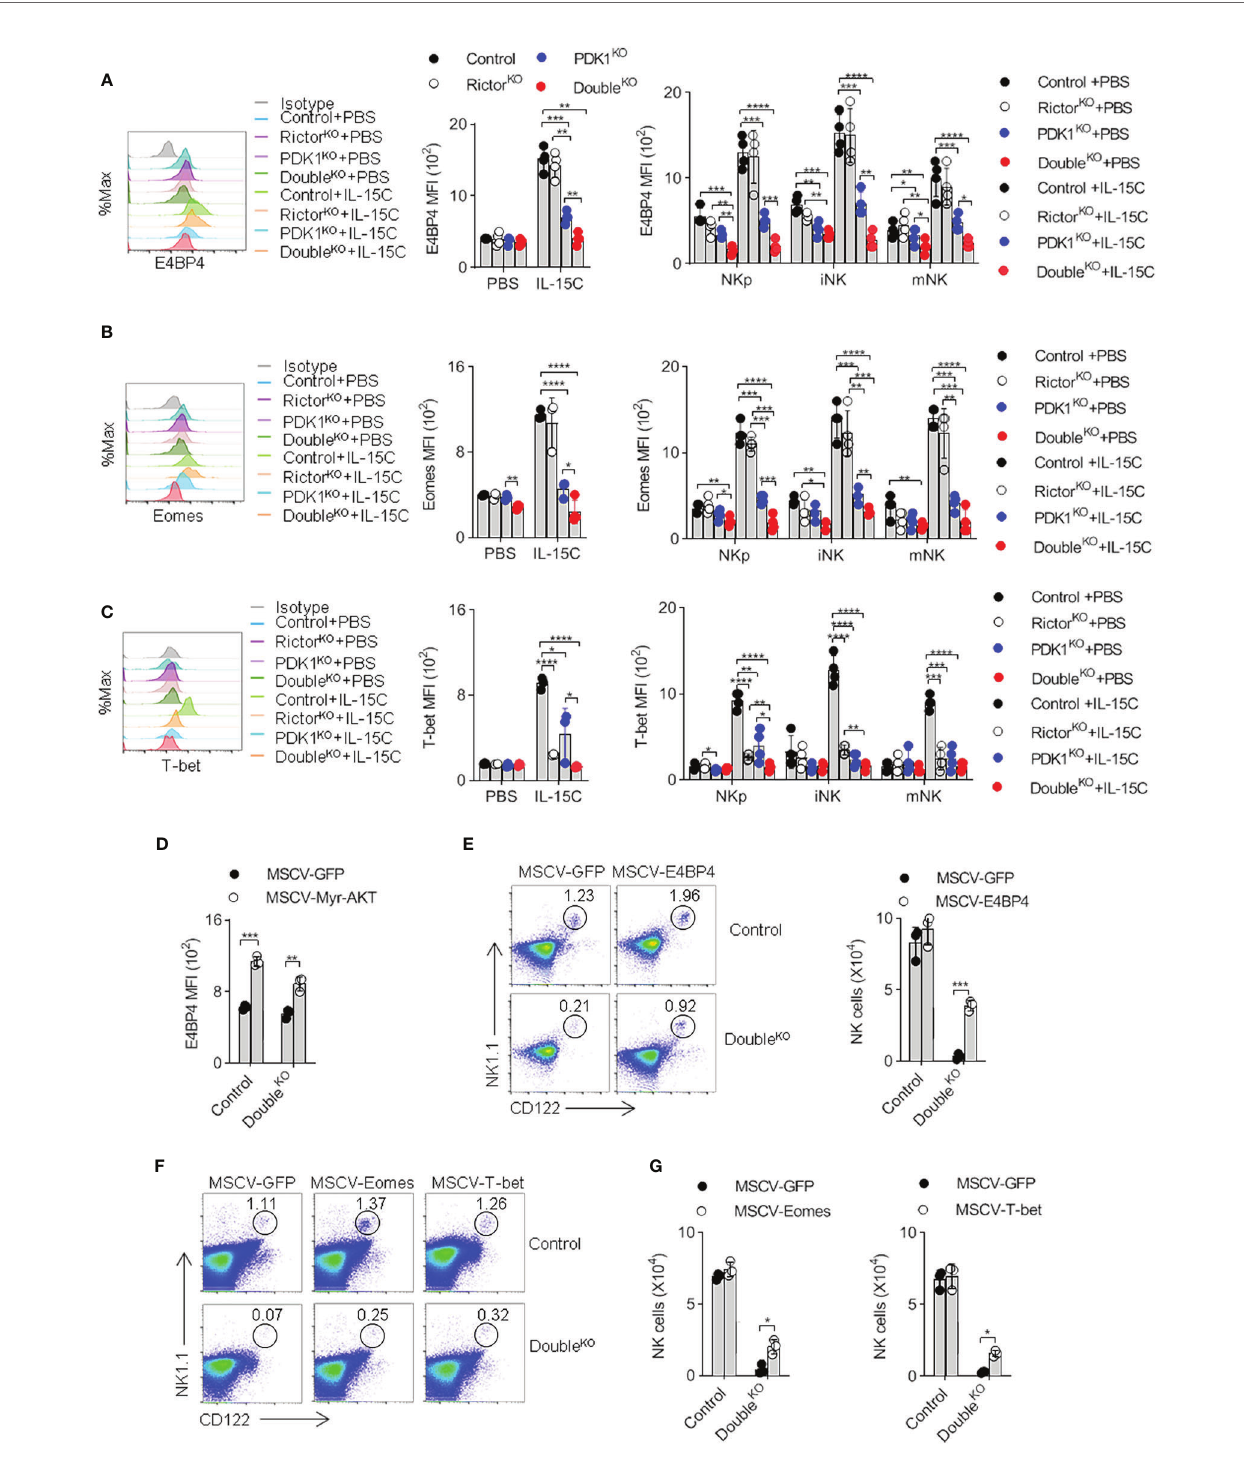
FIGURE 6 | PDK1 and mTORC2 coordinate to regulate the expression of E4BP4 by activating PKB. (A – C) The expressions of E4BP4 (A) , Eomes (B) , and T-bet (C) in total NK cells and NK cells at different stages in mice spleen were examined by fl ow cytometry. Representative overlaid histograms (left), the absolute MFI in total NK cell (middle) and NK cell subsets (left) from mice as annotated. (D) The expression level of E4BP4 in NK cell was examined after replenish Myr-AKT to HSC of Double KO mice. (E – G) The percentage and number of NK cell were analyzed after replenish E4BP4 (E) , Eomes or T-bet (F, G) to HSC of Double KO mice. The data represent one of three independent experiments, n ≥ 3 for each experiment, and values are expressed as the mean ± SD. *p < 0.05, **p < 0.01, ***p < 0.001, ****p <